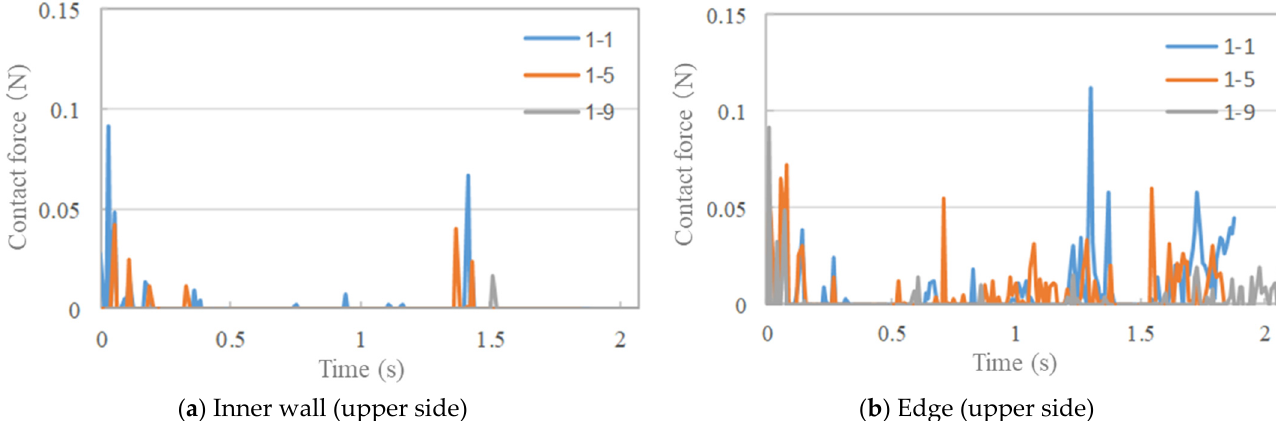
Figure 15. ( a , b ) Time history of contact force between upper elastic wall and tether inside inlet.